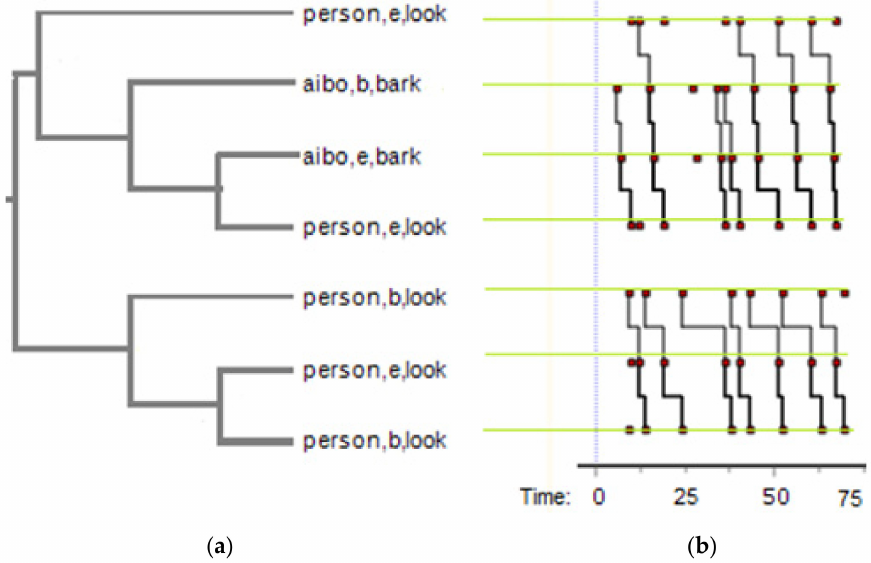
Figure 3. An example of an interactive T-pattern in ThemeEdu software; this is an example pattern extracted from one of the participants while interacting with Aibo. ( a ) The events occurring inside the specific pattern, listed in the order in which they occur within the pattern. The first event in the pattern appears at the top and the last at the bottom; ( b ) The frequencies of each behavior in the pattern, each red dot indicates a single behavior (e.g., the person begins looking, Aibo ends barking, etc.) at a certain time point. The light green lines on the red dots show the behavior which red dots represent. The black lines connecting the red dots represent the patterns between different behaviors. Smaller patterns inside the pattern can also occur when some of the events within the pattern occur without the whole pattern